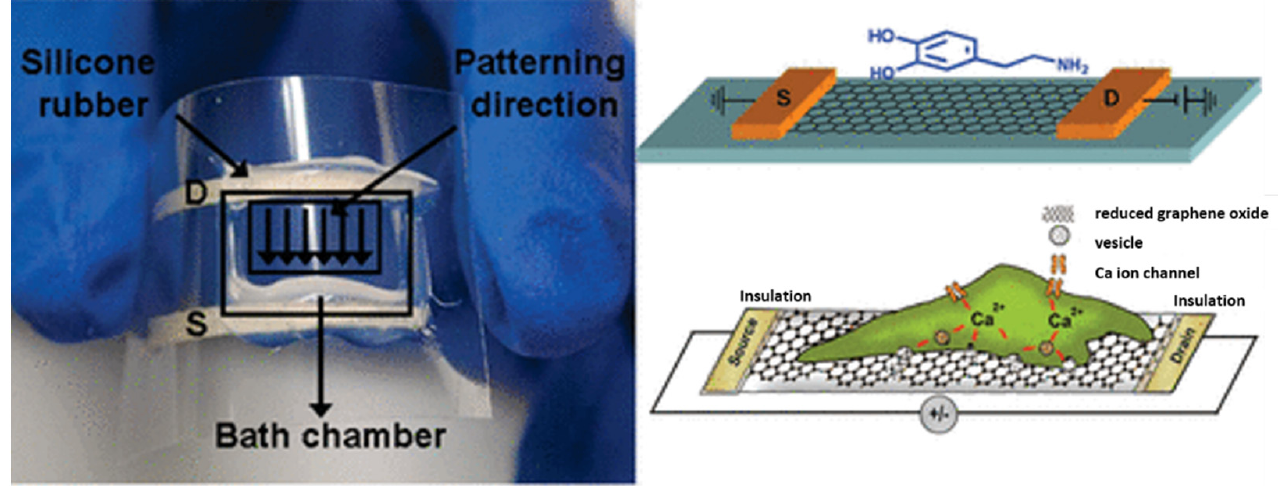
Figure 6. Representation of the rGO FET sensor for the detection of DA. Reprinted with permission from [54]. Copyright© 2010 American Chemical Society.